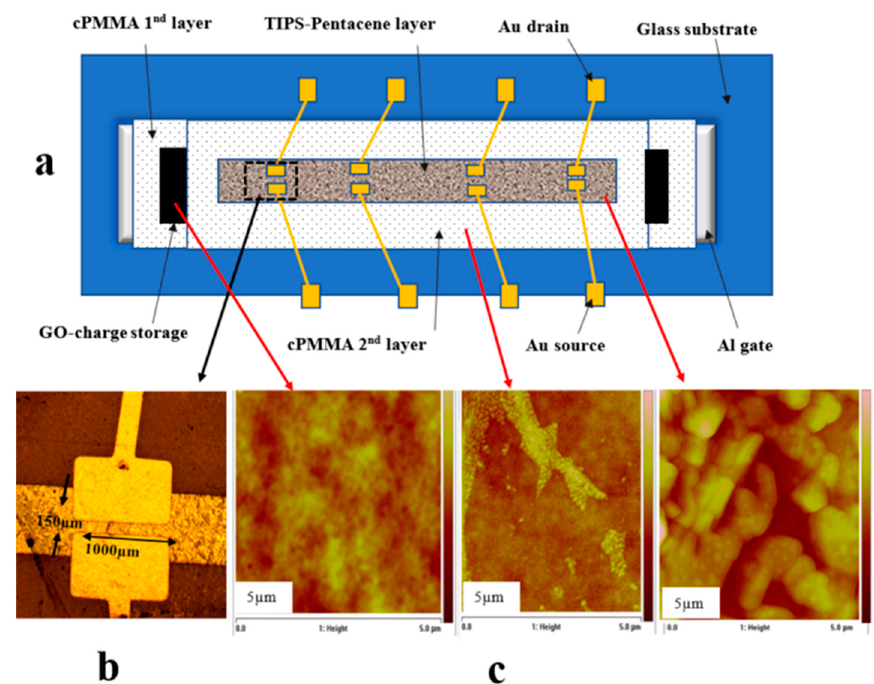
Figure 2. ( a ) Schematic configuration of graphene oxide-based organic memory transistor fabricated on a glass substrate; ( b ) optical microscopic image of the device and its channel; ( c ) the morphological quality and coverage for the cross-linked poly(methyl methacrylate) (cPMMA), graphene oxide, and 6,13-Bis(triisopropylsilylethynyl) pentacene (TIPS)-pentacene